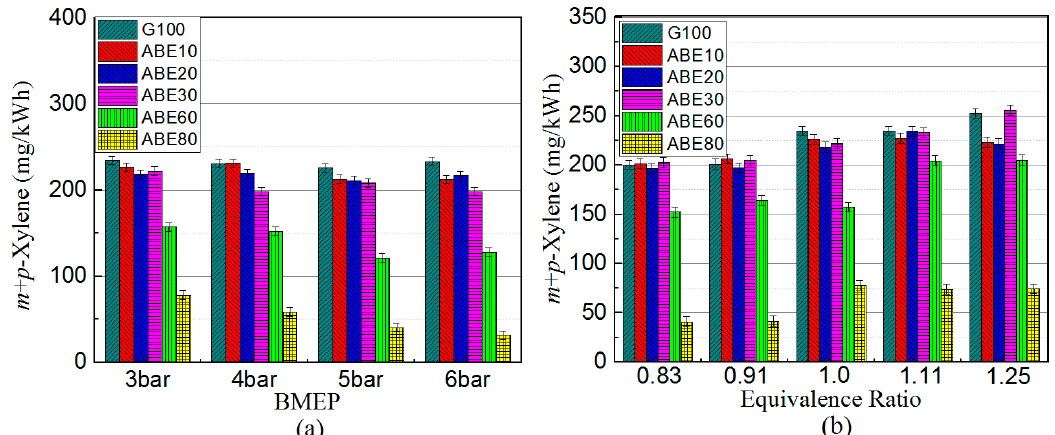
Figure 9. Ethylbenzene emissions at ( a ) stoichiometric conditions under different BMEP, and at ( b ) 3 bar BMEP under different equivalence ratios. Figure 10. m + p -Xylene emissions at ( a ) stoichiometric conditions under different BMEP, and at ( b ) 3 bar BMEP under different equivalence ratios.